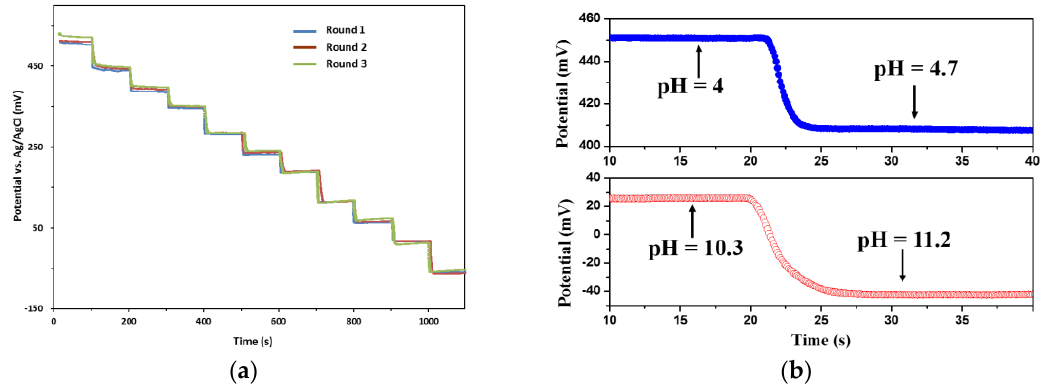
Figure 5. ( a ) The real-time potintial response of the pH sensing electrode; and ( b ) the response time measured from pH = 4.03 to pH = 4.70 ( upper ) and from pH = 10.28 to pH = 11.19 ( lower ).